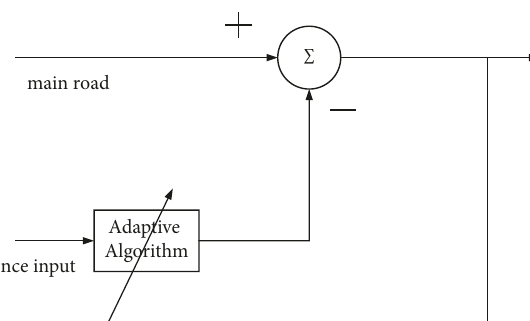
Adaptive Algorithm